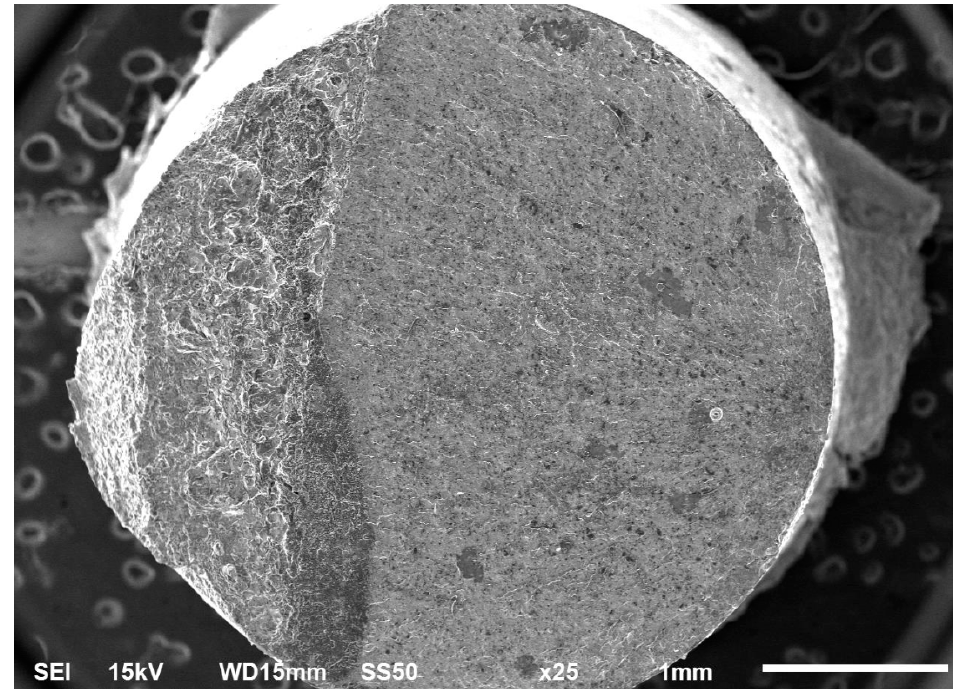
( c ) Fracture surface at –60 °C, 240 MPa, 5.5 × 10 6 cycles. Figure 8. S–N diagram and fracture surface at –60 °C, 240 MPa, Nf = 5.5 × 10 6 cycles.